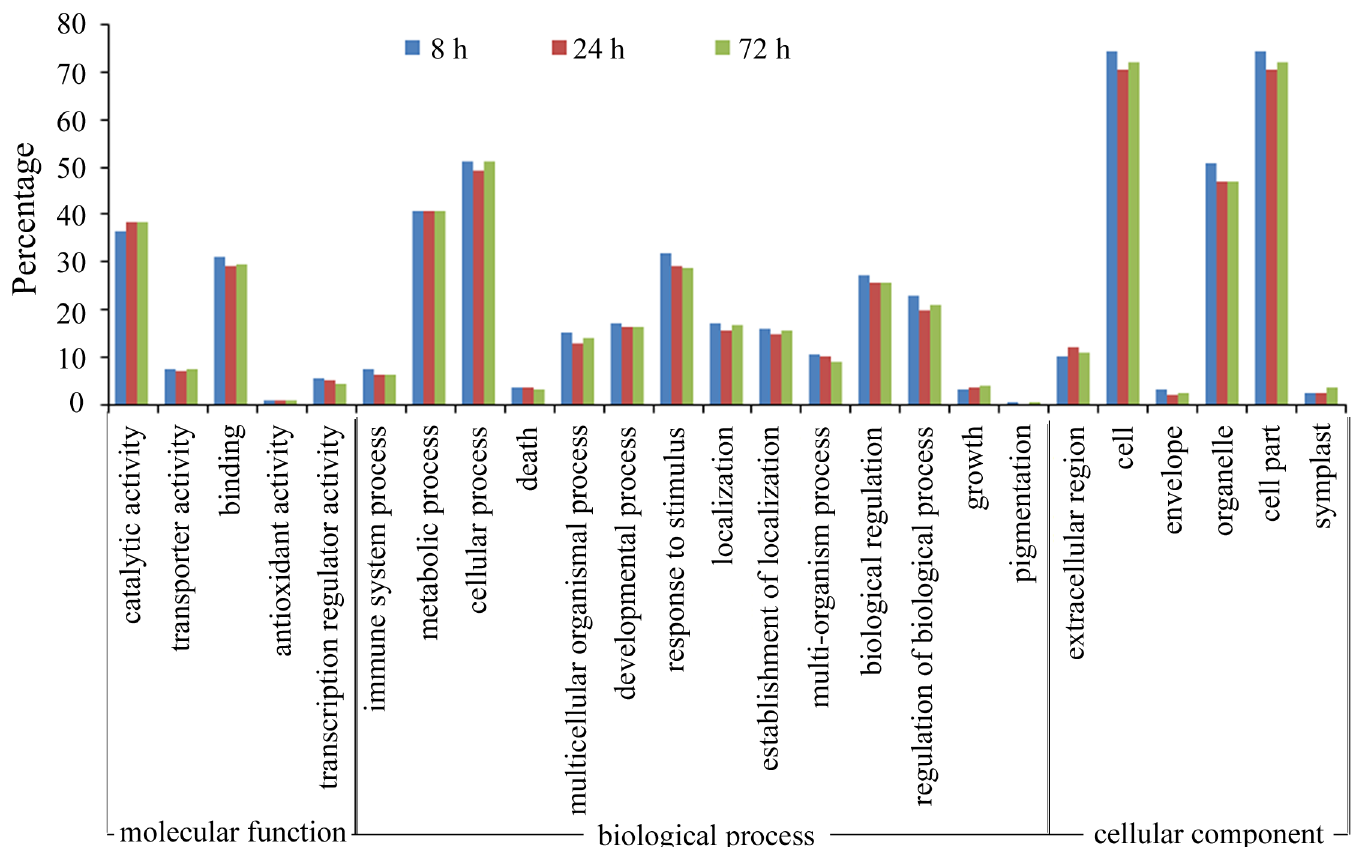
Fig 5. Distribution of the functional GO categories of sugarcane genes that were differentially expressed (P < 0.05) after exposure to low-K stress for 8, 24 and 72 h.